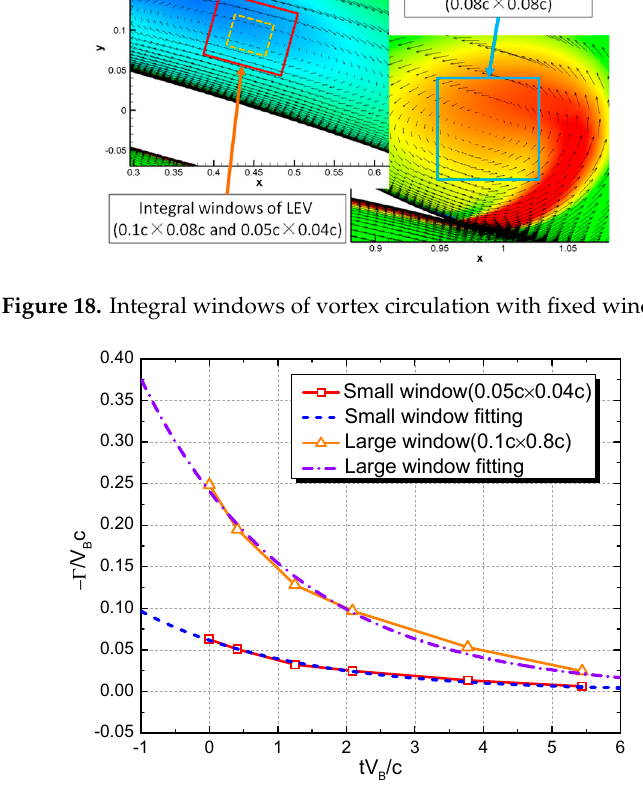
Figure 19. Comparisons of LEV dissipation between different integral windows ( 0.5 λ= ).